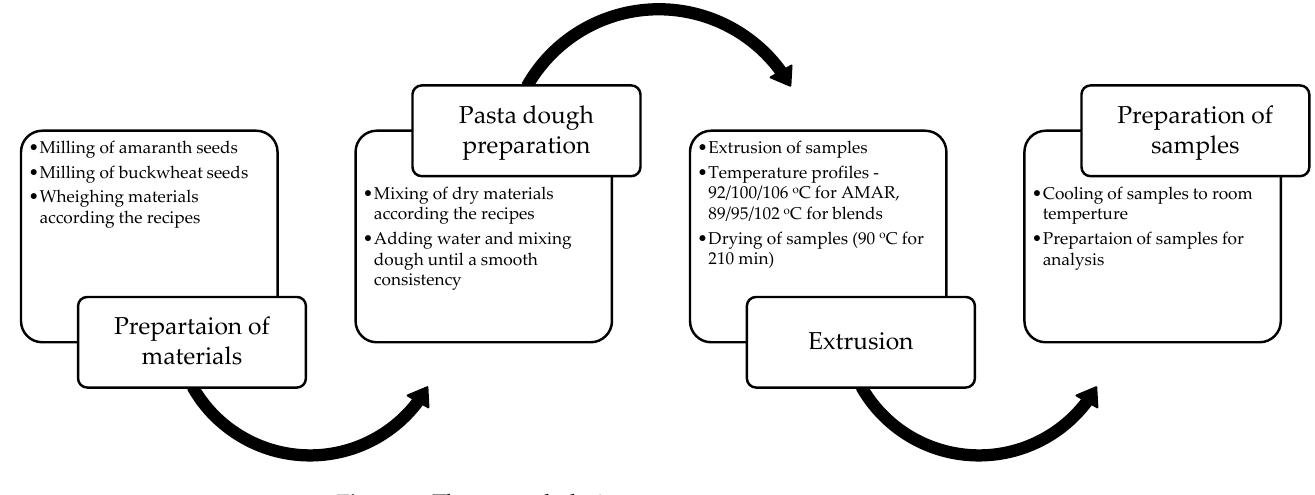
Figure 2. The research design.